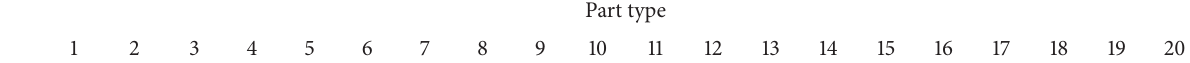
Table 8: Partial input data for Example 2.